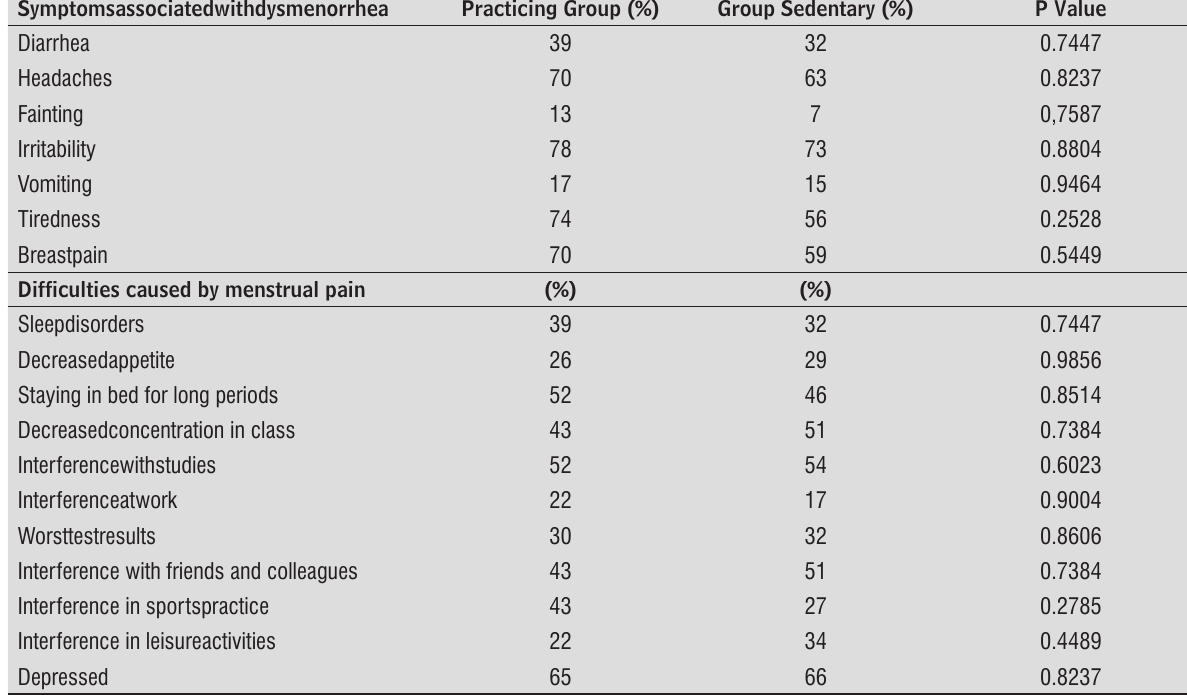
Table 2 - Comparison of percentage values of symptoms associated with dysmenorrhea and p value, of both groups